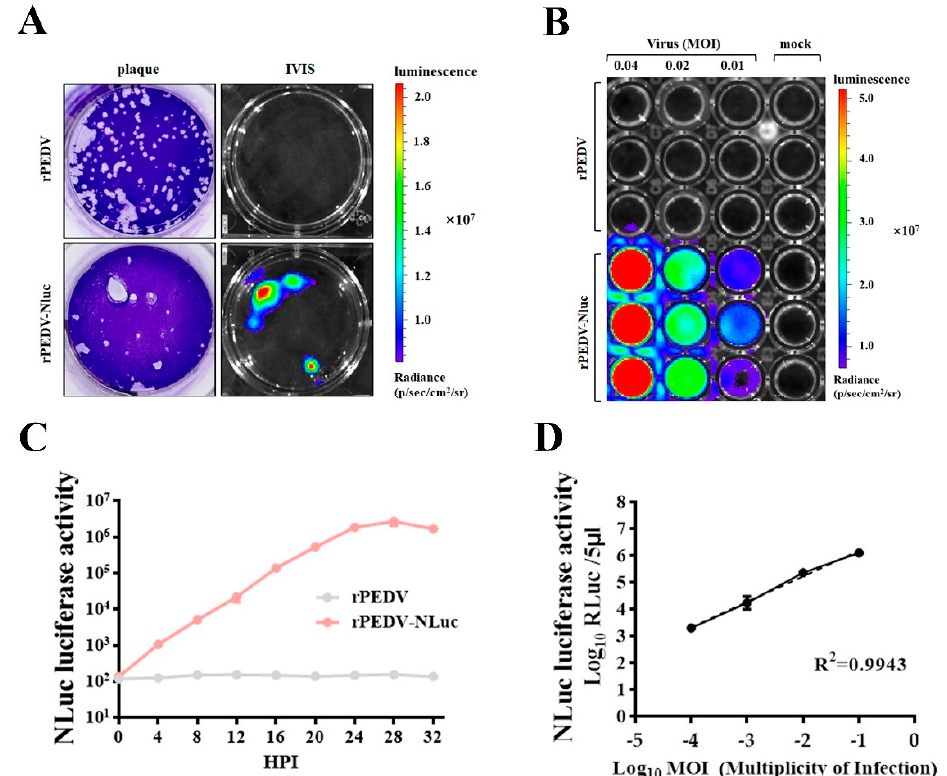
Figure 3. Assessment of rPEDV-NLuc replication via luciferase assay. ( A ) Nanoluciferase imaging of plaques from Vero cells infected with rPEDV-NLuc. Vero cells were infected with rPEDV-NLuc at an MOI of 0.001 or rPEDV at an MOI of 0.01. At 36 h post-infection, plaques formed by PEDVs were visualized as luminescent signals using the In Vivo Imaging System (IVIS). ( B ) Vero cells were infected with rPEDV and rPEDV-NLuc at different MOIs. At 20 h post-infection. NLuc substrate was added to each well and luminescent signal were detected by IVIS. ( C ) The replication kinetics of rPEDV-NLuc was quantified by luminometry. Vero cells were infected with rPEDV and rPEDV-NLuc at an MOI of 0.01, and the luminescent signals were quantified by luminometry at the indicated times. Data are represented as the mean ± SD ( n = 3). ( D ) Vero cells were infected with rPEDV-NLuc at the different MOIs, and the luminescent signals of cell lysates were tested at 20 h post-infection by the Nano-Glo Luciferase Assay System (Promega). The analysis of correlation between virus input and bioluminescent signal was analyzed by GraphPad Prism 7.0. Data are represented as the mean ± SD ( n = 3).